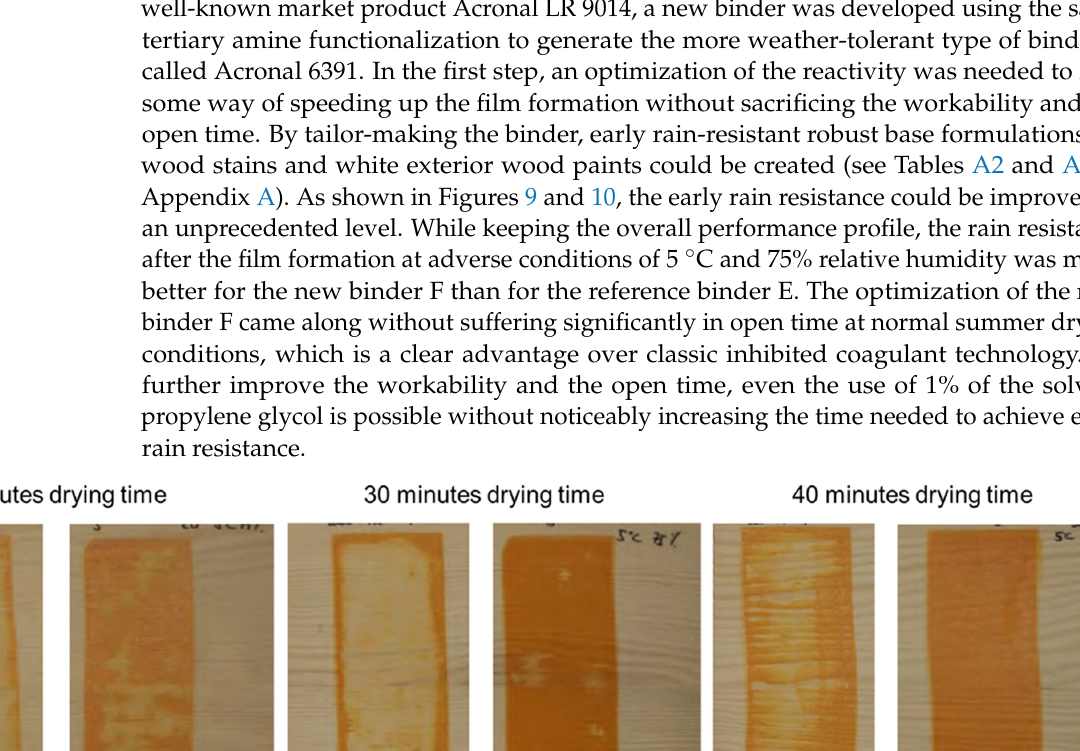
Section 2.2. The temperature during drying was 5 ◦ C, and the humidity was approximately